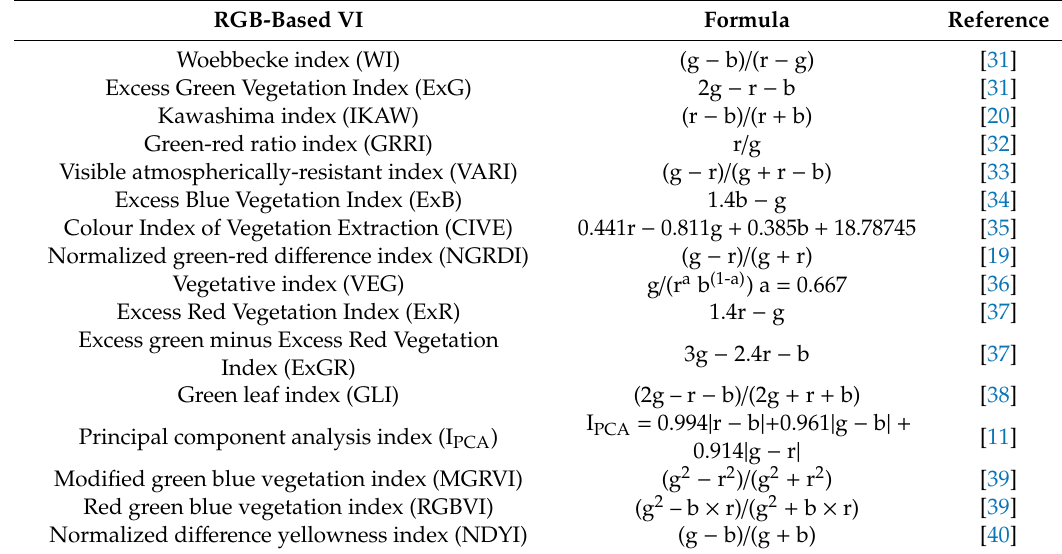
Table 1. Definitions of the RGB-based vegetation indices (VIs) used in this study. RGB-Based VI Formula